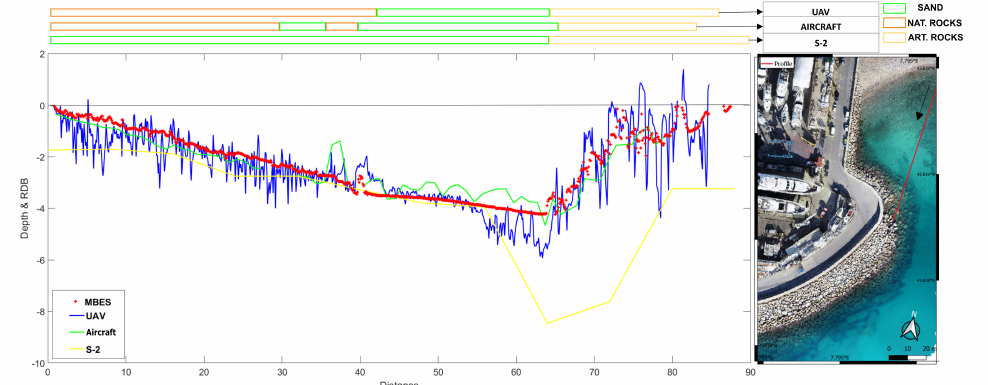
Figure 21. Comparison between MBES and RDBs for the three platforms along a transect (in the red line on the orthophoto on the right), with the indication of the respective classifications, Portosole (beach area